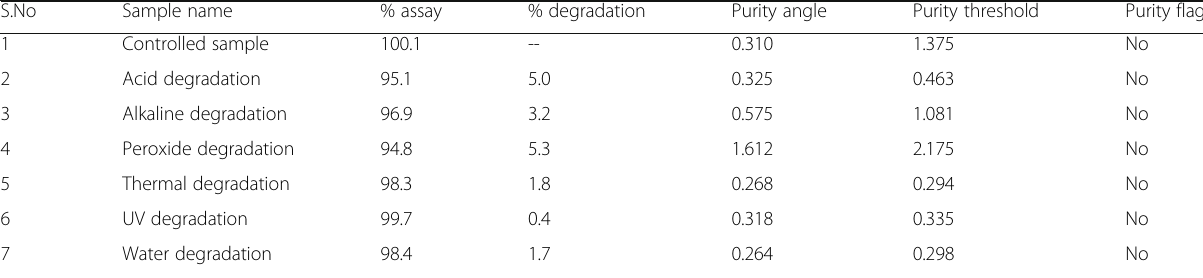
Table 10 Forced degradation study results for lamivudine S.No